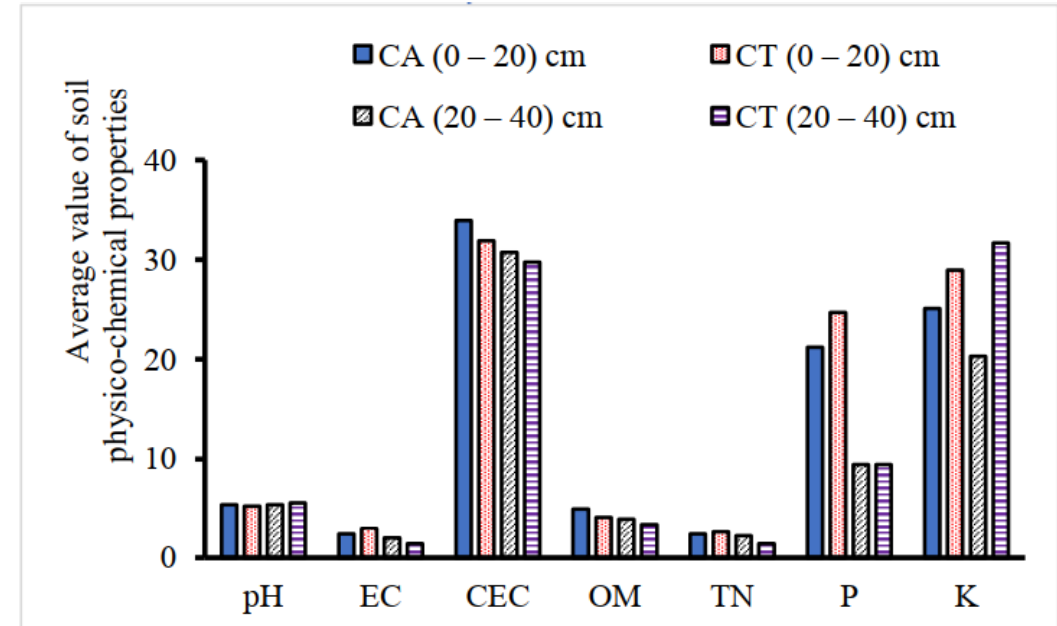
Figure 4. Average soil physico-chemical analysis result for CA and conventional tillage (CT) in which soil samples were taken from topsoil (0–20 cm) and subsoil (20–40 cm) from Dangishta experimental site. Note: Electrical conductivity (EC) and total nitrogen (N) values are multiples of ten, Potassium (K) is quotient of ten.